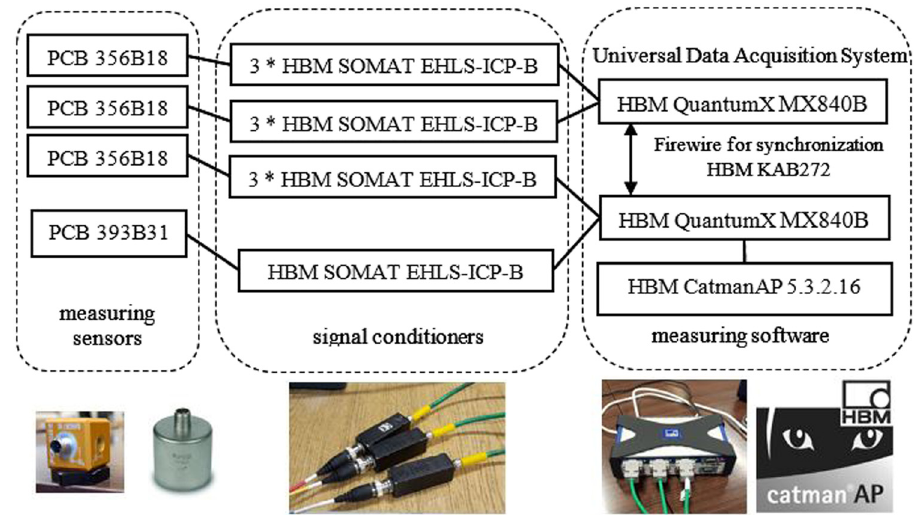
Figure 2: Measurement path.